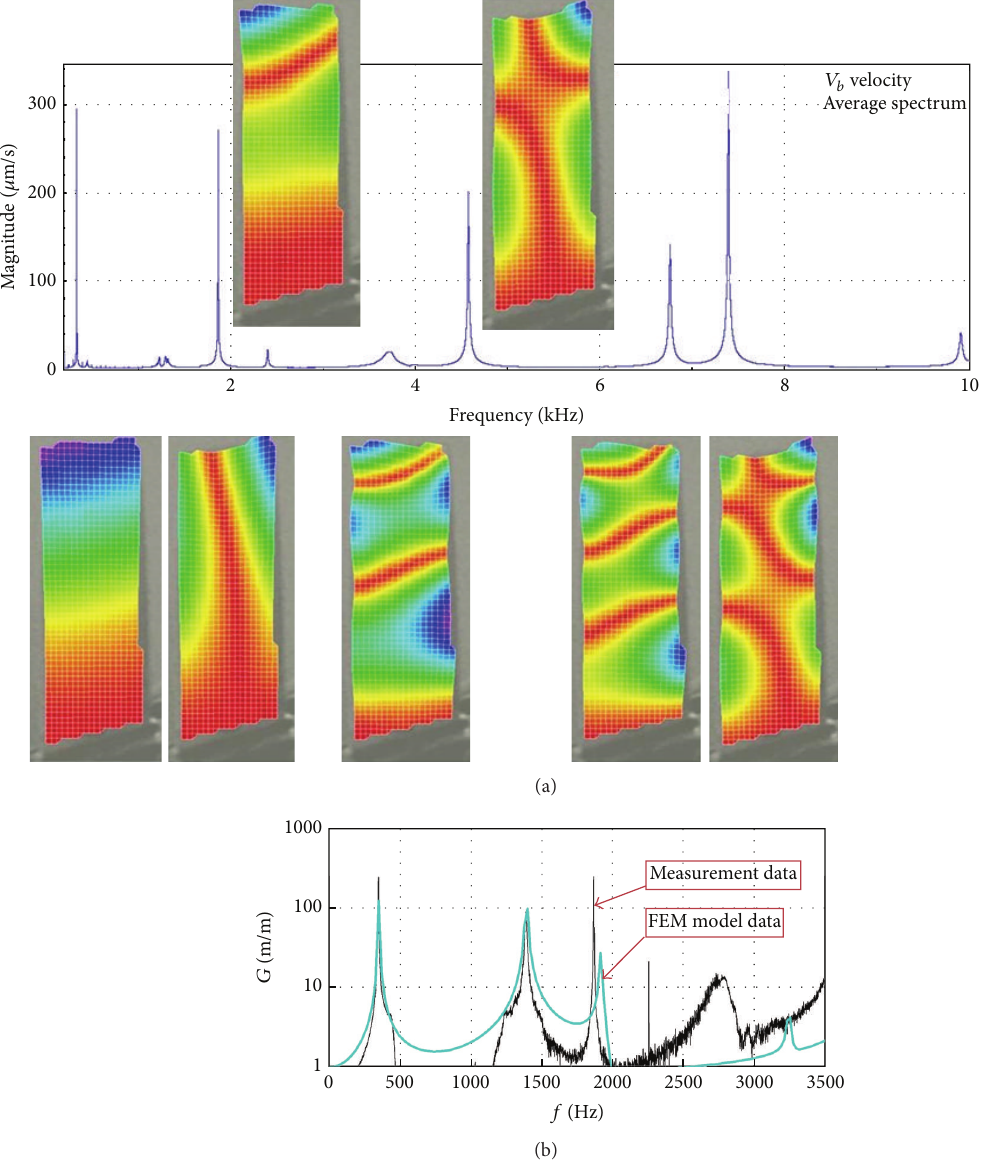
Figure 26: Identification of blade modal properties using (a) PZT exciter and laser scanning vibrometer (906 test points); (b) experimental data and FEM model of the steel blade (before the FEM model is tuning) [3,